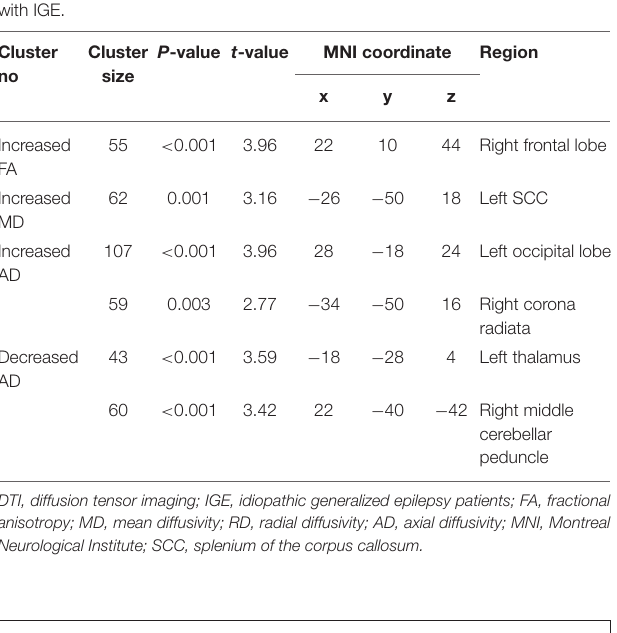
TABLE 2 | Location of brain regions with altered DTI measurements in patients with IGE.